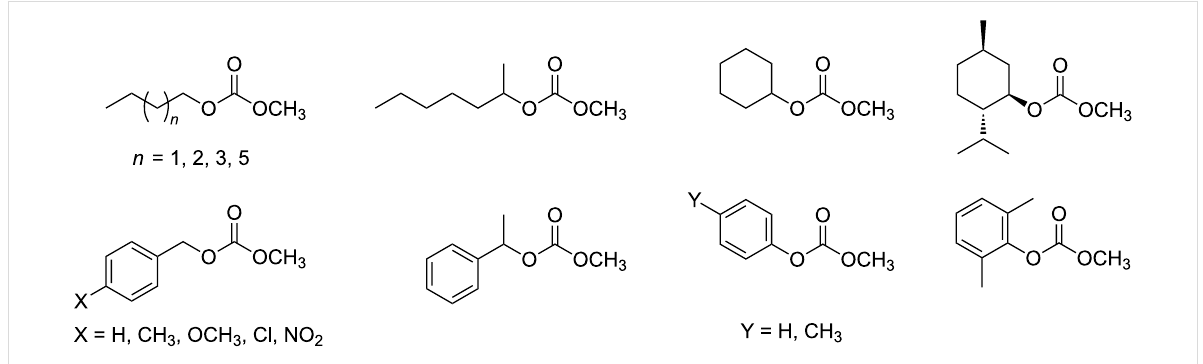
Figure 4: Acyclic non-symmetrical organic carbonates synthetized with 1-(trimethoxysilyl)propyl-3-methylimidazolium chloride as the catalyst.